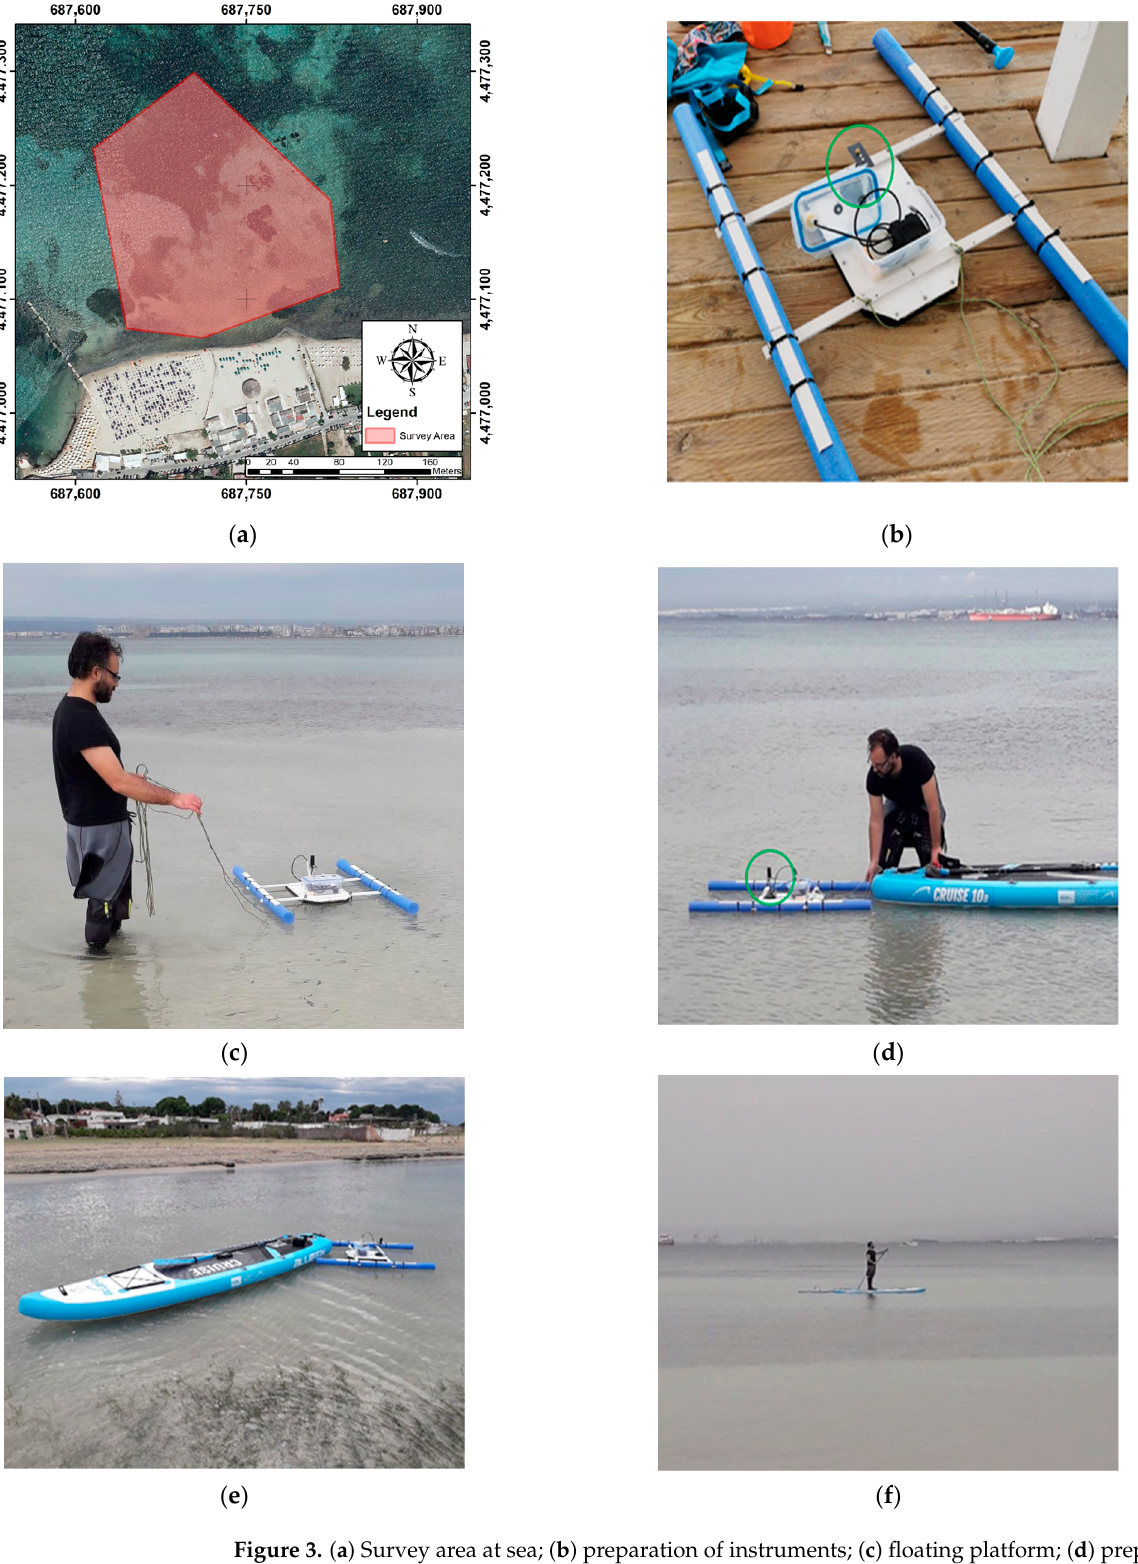
Figure 3. ( a ) Survey area at sea; ( b ) preparation of instruments; ( c ) floating platform; ( d ) preparation of SUP for the survey; ( e ) floating platform connected to SUP; ( f ) survey at sea.